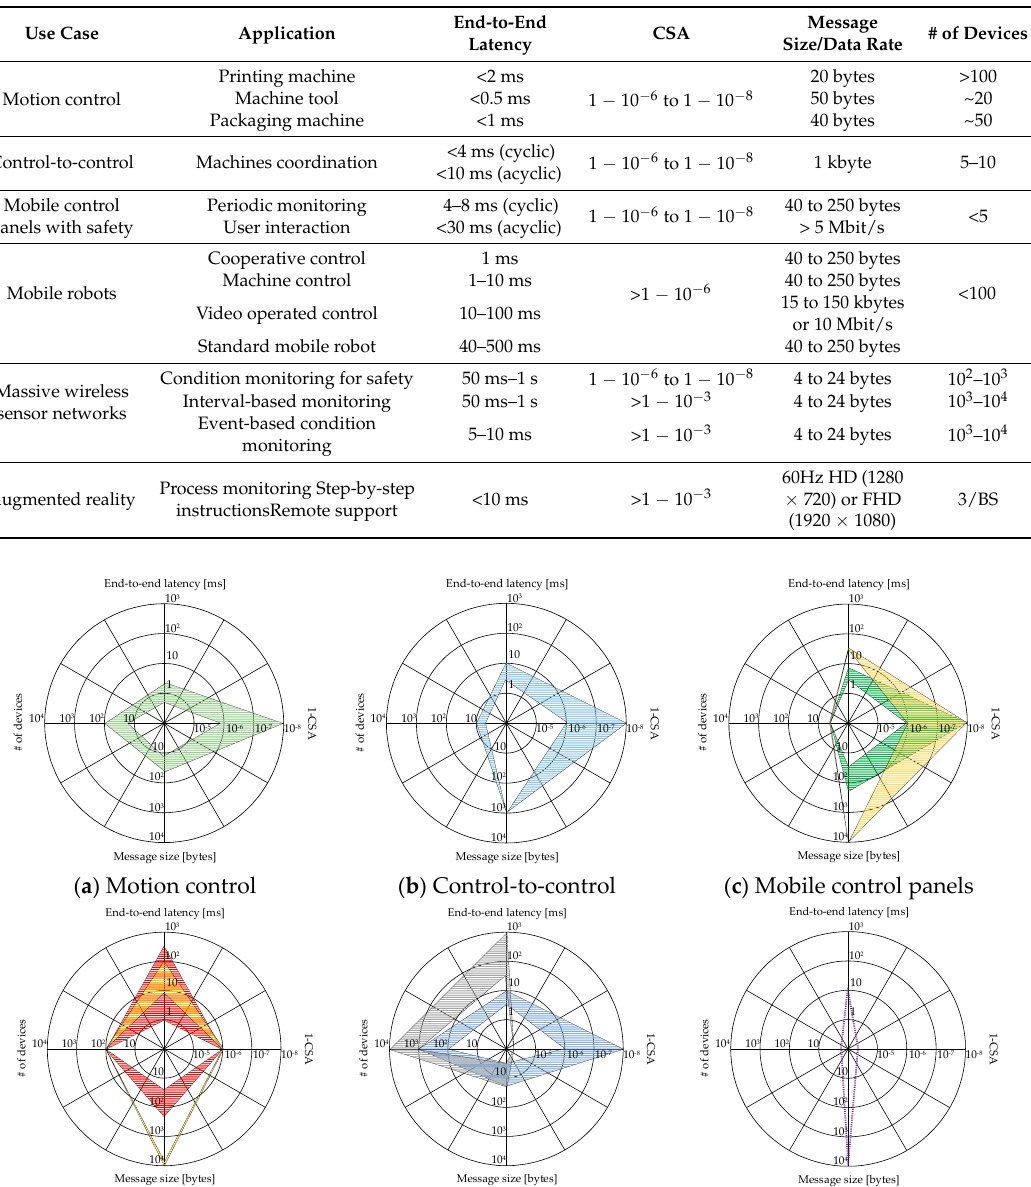
Table 1. Requirements of selected use cases for the factory of the future.